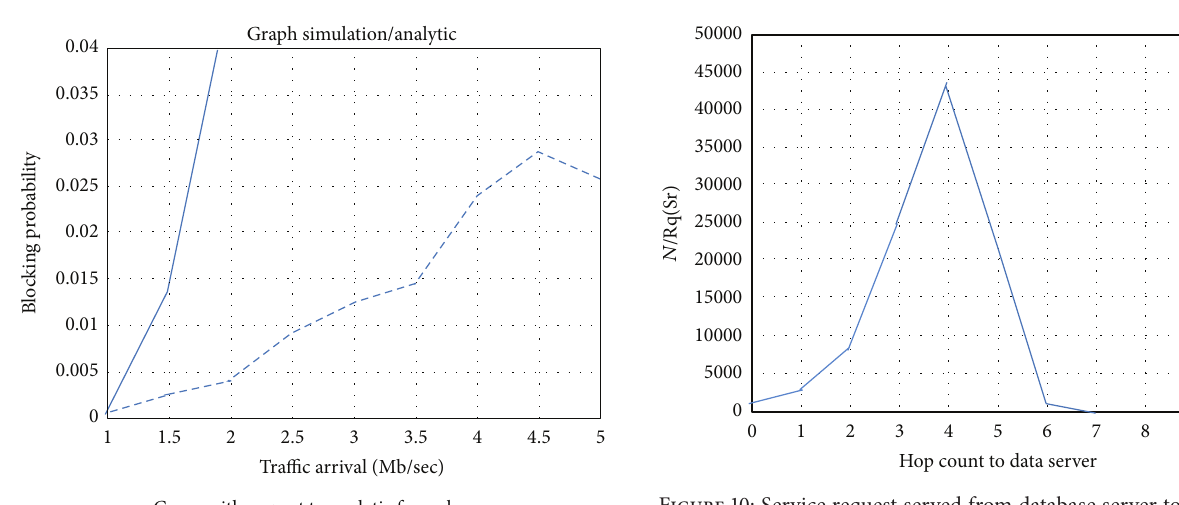
Figure 10: Service request served from database server to applica- tion server (orientation 1).